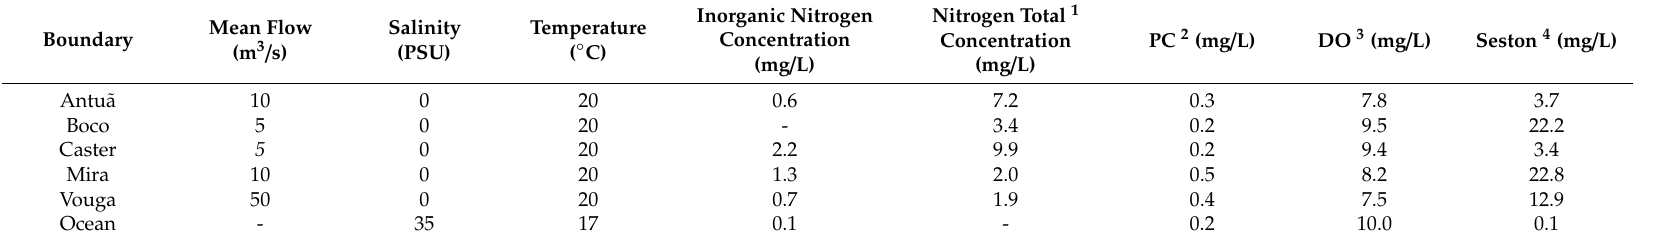
Table 1. The model boundary conditions, according to data [56–61].